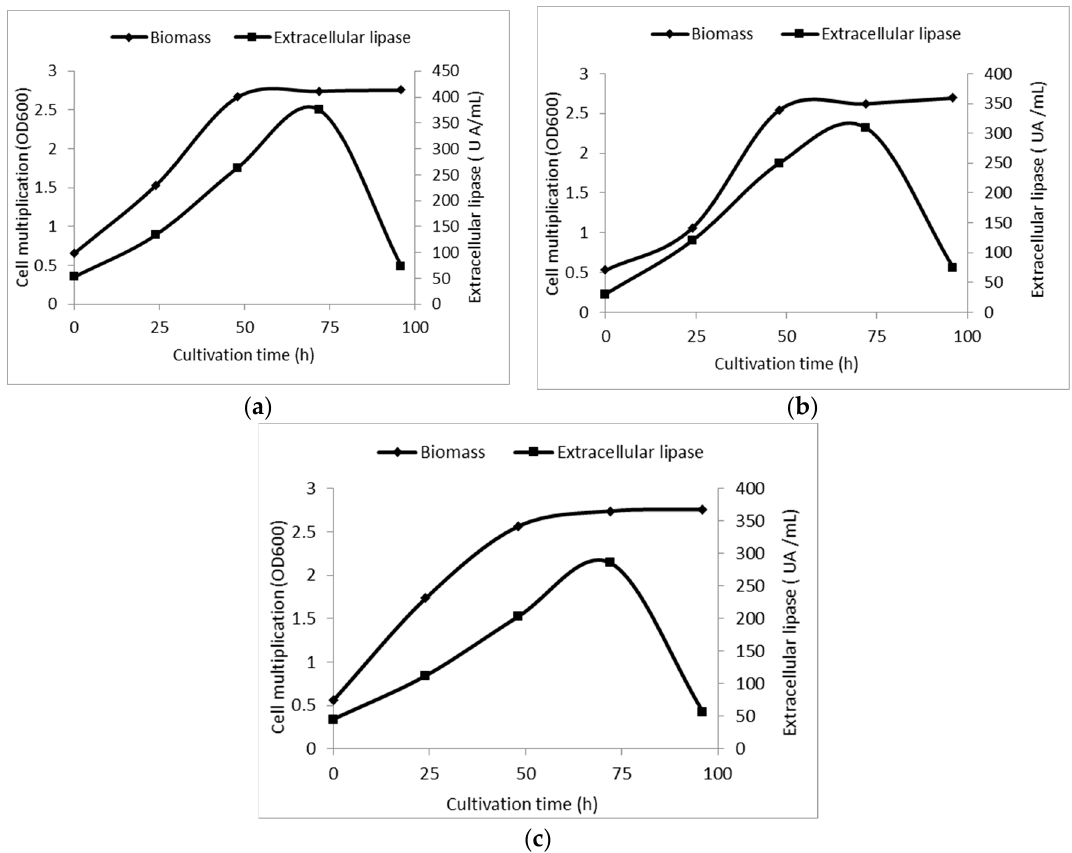
Figure 4. Kinetics of biomass accumulation and extracellular lipase production by Yarrowia lipolyti ca strains, coded MIUG RD 14 ( a ), MIUG RD 15; ( b ) MIUG RD 16; ( c ) during submerged cultivation (180 rpm at 28 °C) on nutrient broth supplemented with chemicals.